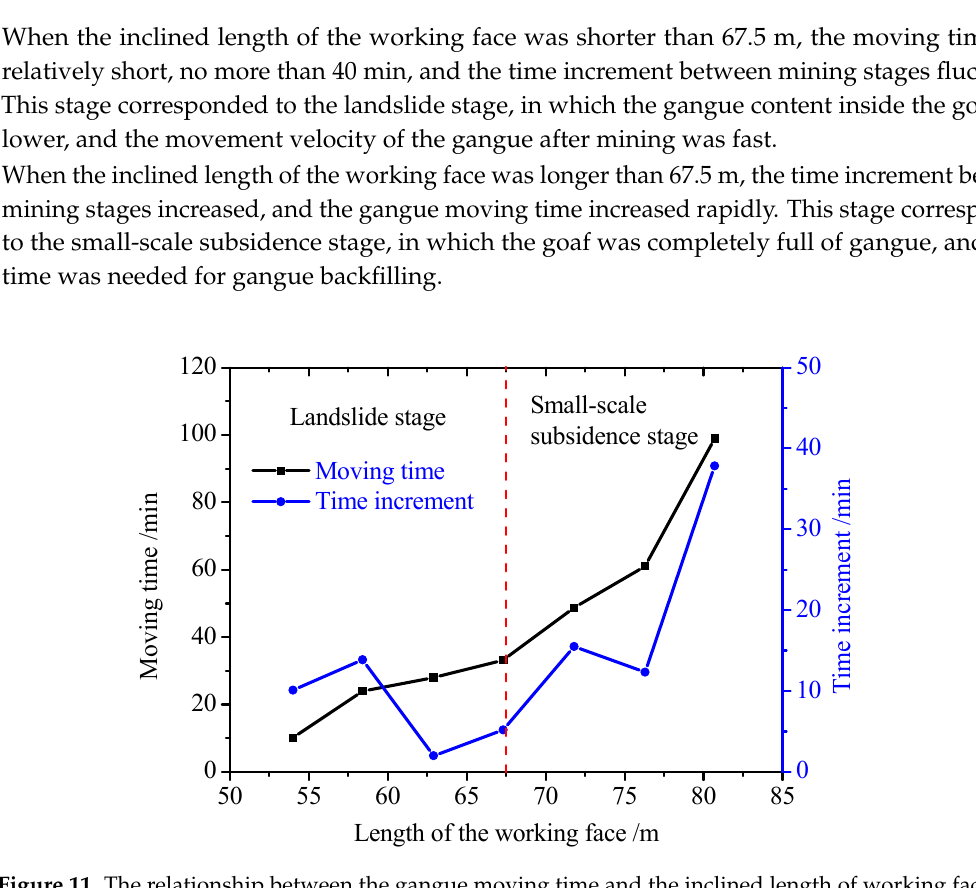
Figure 11. The relationship between the gangue moving time and the inclined length of working